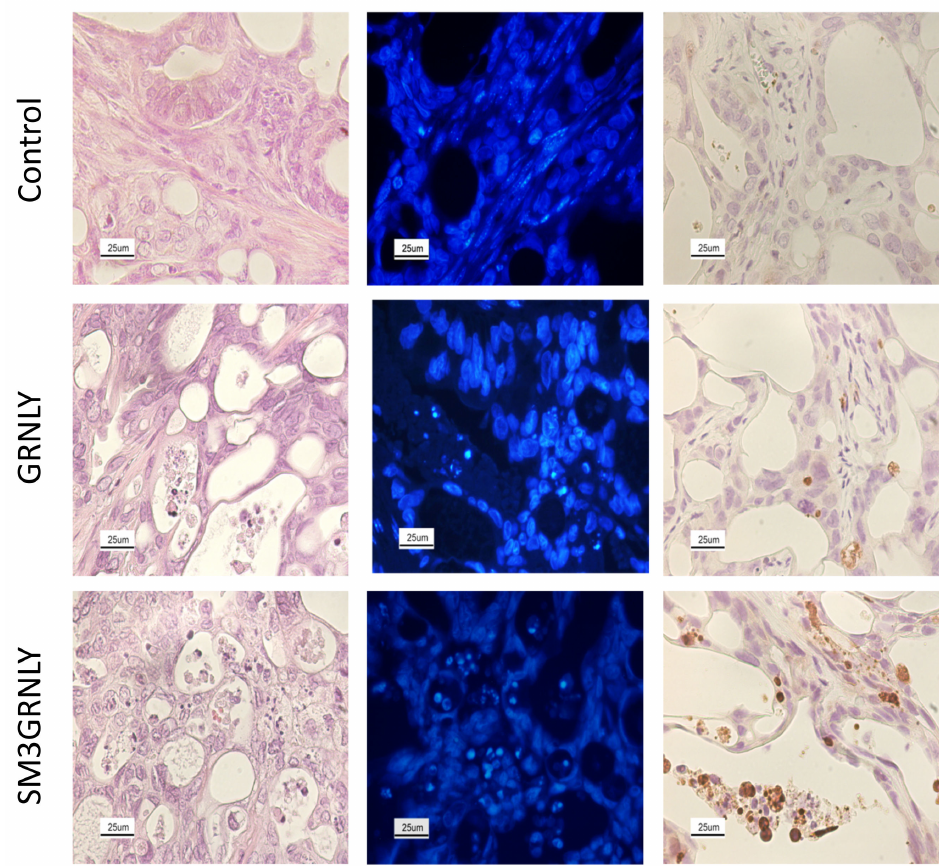
Figure 10. Hematoxylin-Eosin staining ( left ), DAPI nuclear staining ( middle ) and activated caspase-3 immunohistochemistry ( right ) of tumors derived from CAPAN-2 xenografts. Representative images of histological sections of tumors from mice treated with PBS ( first row), GRNLY ( second row) or SM3GRNLY ( third row). Image magnification was used at 400 ×